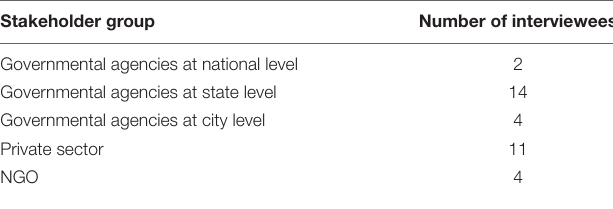
TABLE 1 | Number of interviewees per stakeholder